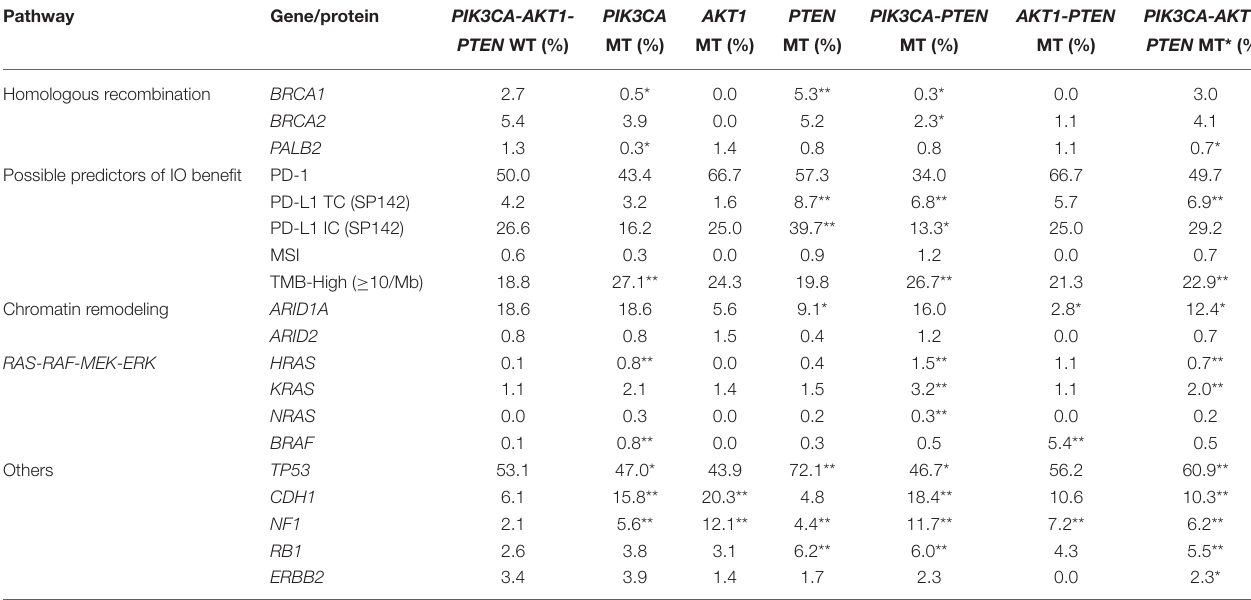
TABLE 2 | Summary of biomarker subgroup co-alterations for all subtypes. Pathway Gene/protein